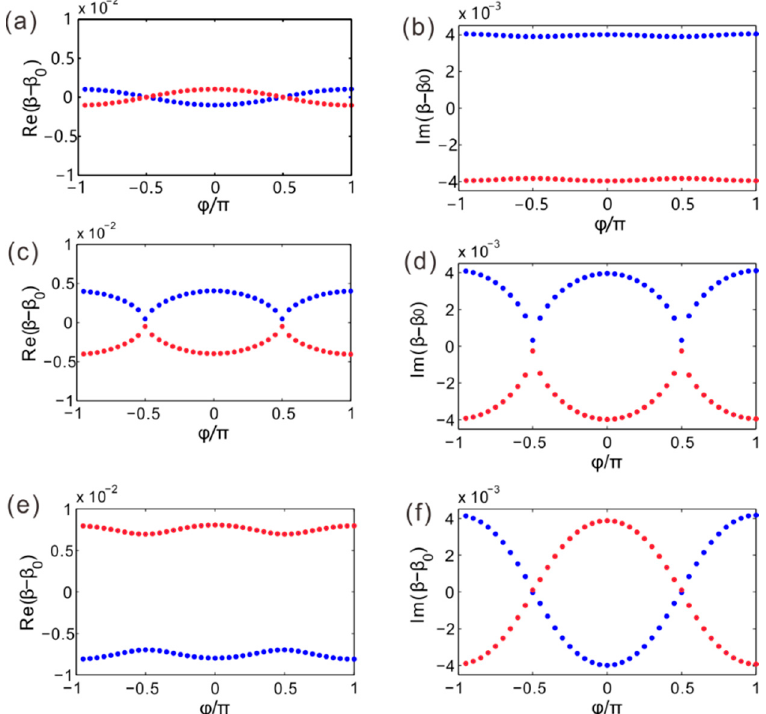
Figure 3. The numerical band structures of periodic waveguide arrays for different coupling strengths. ( a ) and ( b ) are the real part and imaginary part as c 1 = 1 × 10 − 3 μ m − 1 and c 2 = 4 × 10 − 3 μ m − 1 ( c ) and ( d ) are the real part and imaginary part as c 1 = c 2 = 4 × 10 − 3 μ m − 1 . ( e ) and ( f ) are the real part and imaginary part as c 1 = 8 × 10 − 3 μ m − 1 and c 2 = 4 × 10 − 3 μ m − 1 .